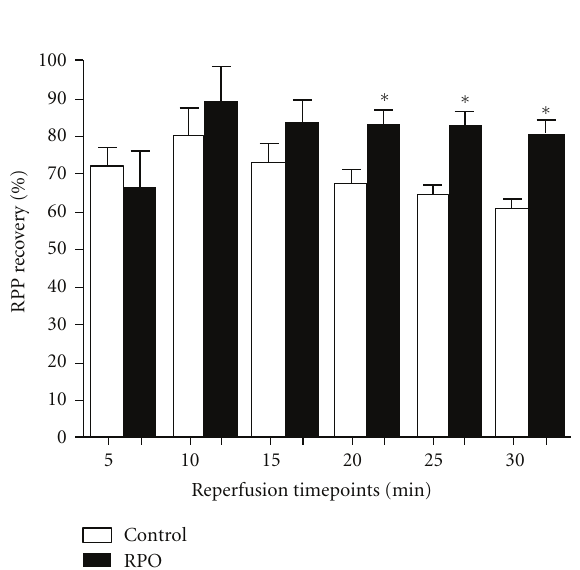
Figure 2: The E ff ect of RPO on RPP recovery (%). Results are expressed as mean ± SEM, ( ∗ P < 0 . 05 for indicated groups). (Con- trol, n = 7 and RPO, n = 7) RPO-Red